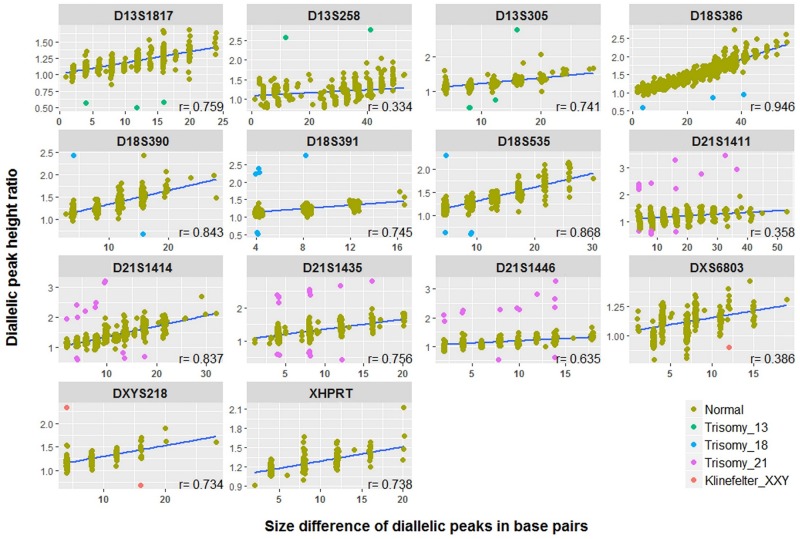
Graphical presentation of the interdependence between the height ratios and the size differences for the diallelic STR markers, given separately for each marker.Correlation coefficients (r) and regression lines for each marker were calculated from normal 1:1 genotypes, while trisomic diallelic genotypes are presented for illustrative purposes only. All samples were run on the ABI 3500 Genetic Analyzer and analyzed with the GeneMapper 4.1 software. The threshold for a minimum peak height detection for each dye was set to ‘factory defaults’ of 50 relative fluorescence units (RFU). The number of height ratios by marker is given in S2 Fig.